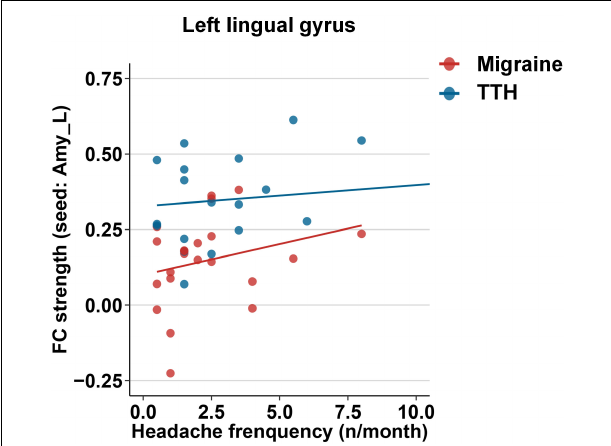
FIGURE 6 | Associations between the rsFC strength of the left amygdala with the left lingual gyrus and headache frequency in migraine (red) and TTH (blue) groups. Only the association in migraine group (red) reached statistical significance after Bonferroni correction. The associations of headache characteristics with rsFC strengths in the significant regions were tested using multiple linear regression model with age, gender, and educational years as covariates. Specific β coefficients and p -values can be found in Additional File 1. TTH, tension-type